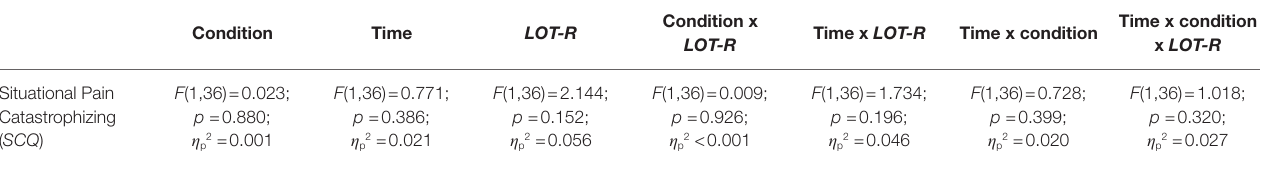
TABLE 3 | F -Tests, value of p and effect sizes of the ANCOVA with the factors condition (between-subjects, levels: BPS and TD), time (within-subject, levels: pre and post) and the covariate dispositional optimism (Life Orientation Test-Revised: LOT-R ) for the dependent variable situational pain catastrophizing.